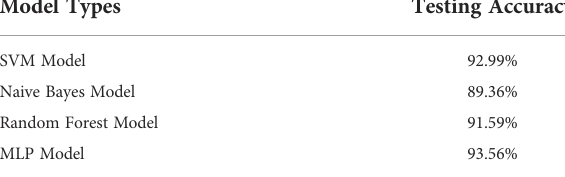
FIGURE 13 Overview of the study design.